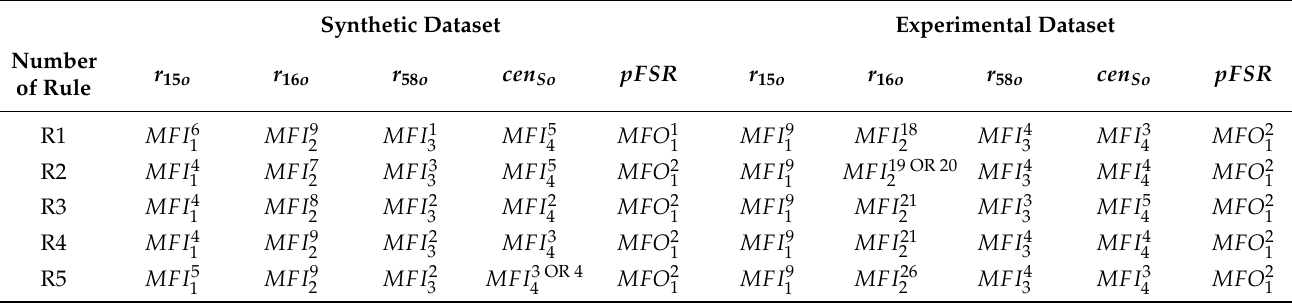
Figure 10. Simulated ( a ) peaks wavelength positions, ( b ) some amplitude ratios and ( c ) centroid of the spectrum as a function of temperature of sensor 2; ( d ) comparison between T est and T ref ; ( e ) AE and ( f ) SE distributions of the for T est obtained considering different input combinations. Table 5. Inference Rules of the FIS1 for Sensor